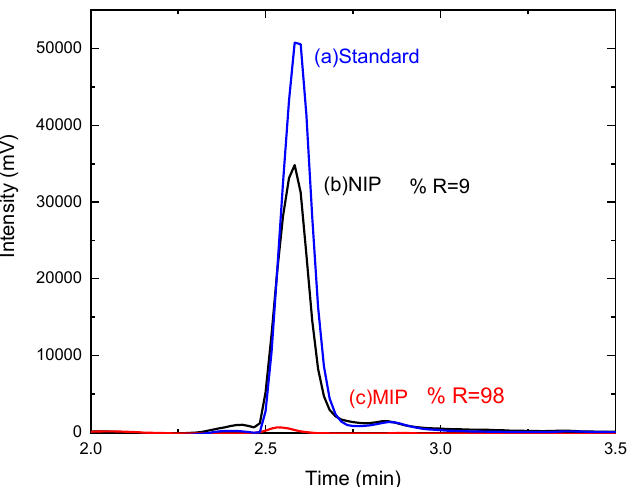
Figure 6. HPLC spectra obtained for the standard material (a), MMIPs after adsorption (b), and MNIPs (c). Conditions applied: methanol: phosphoric acid in the ratio of 60:40; wavelength: 280